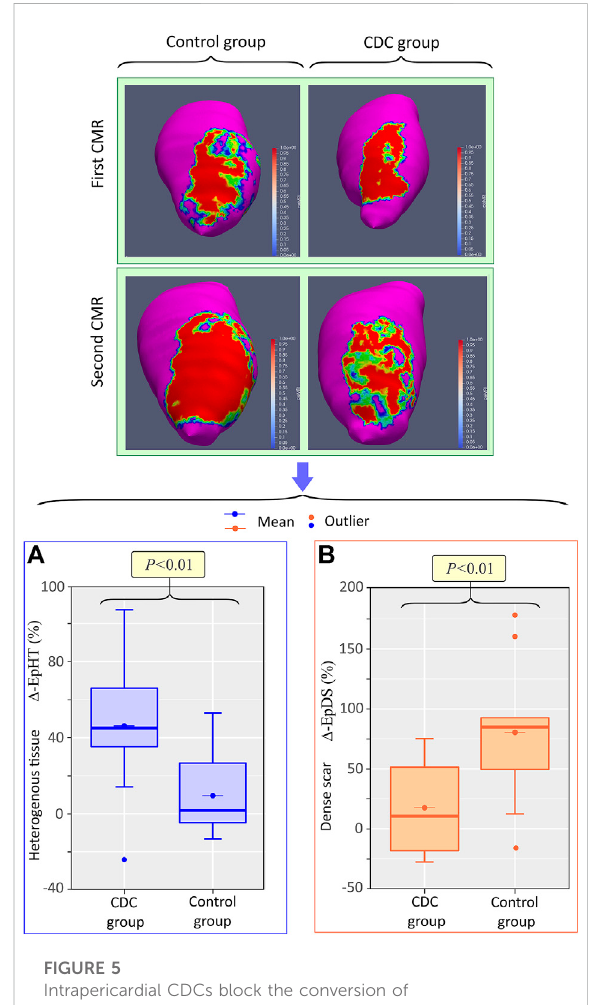
FIGURE 5 Intrapericardial CDCs block the conversion of heterogeneous tissue into dense scar in the epicardium. Top: epicardial signal intensity maps of a treatment and control animal inthe fi rstandsecondCMR.RedrepresentsDS,magentaHM, and green-yellow HT. Bottom: boxplots showing the differences in relative percentage changes in epicardial heterogeneous tissue, EpHT (A) and dense scar, EpDS (B) Abbrv: CDC = cardiosphere- derived cells, CMR = cardiac magnetic resonance, Δ EpDS = percentage change in epicardial heterogeneous tissue, Δ EpHT = percentage change in epicardial heterogeneous tissue.